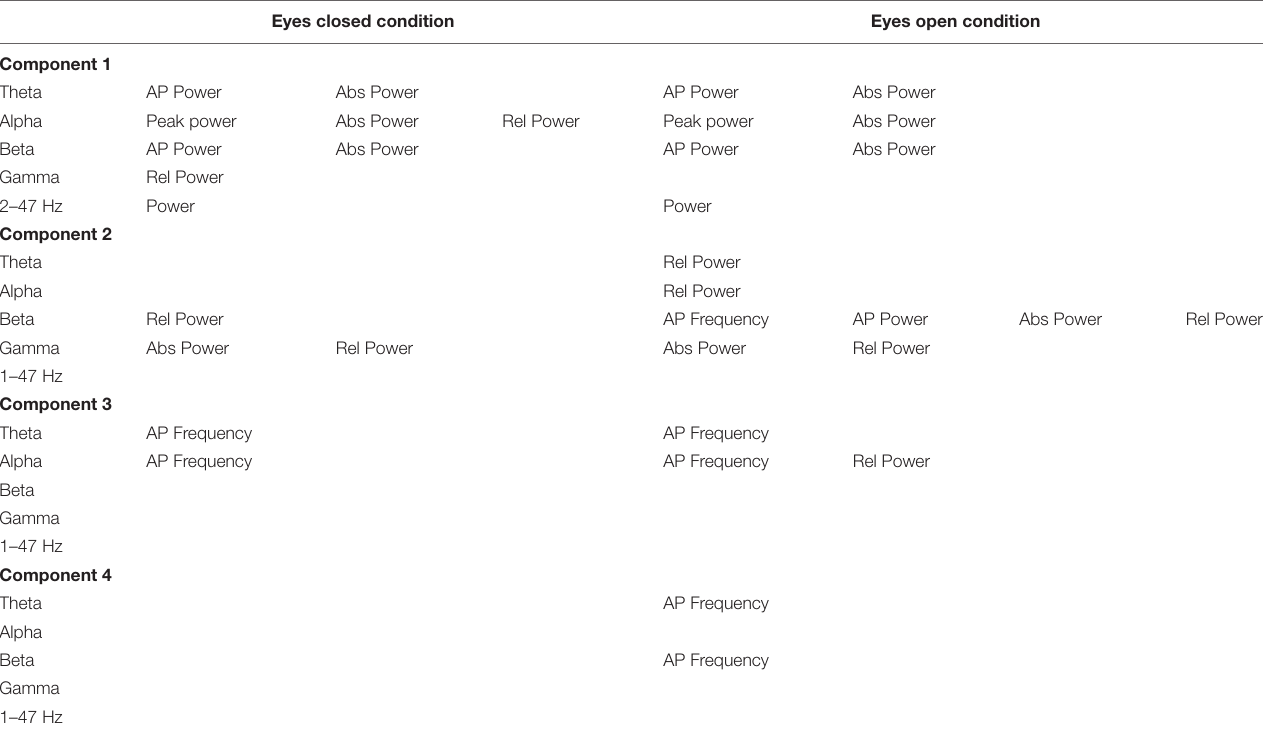
TABLE 2 | EEG measures that contributed to the four components retained from the PCA analysis. Eyes closed condition Eyes open